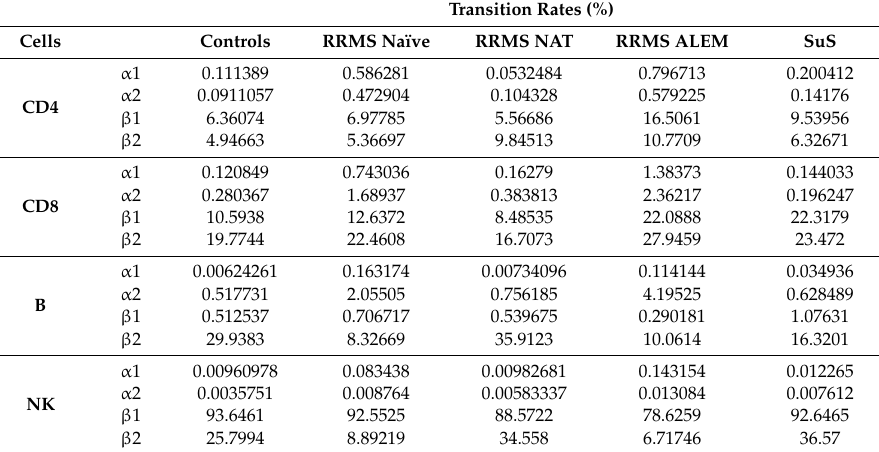
Table 2. Transition rates of lymphocyte subsets based on Markov chain model. The rates indicate the percentage of cells transitioning from (i) naïve lymphocytes in the PB compartment to